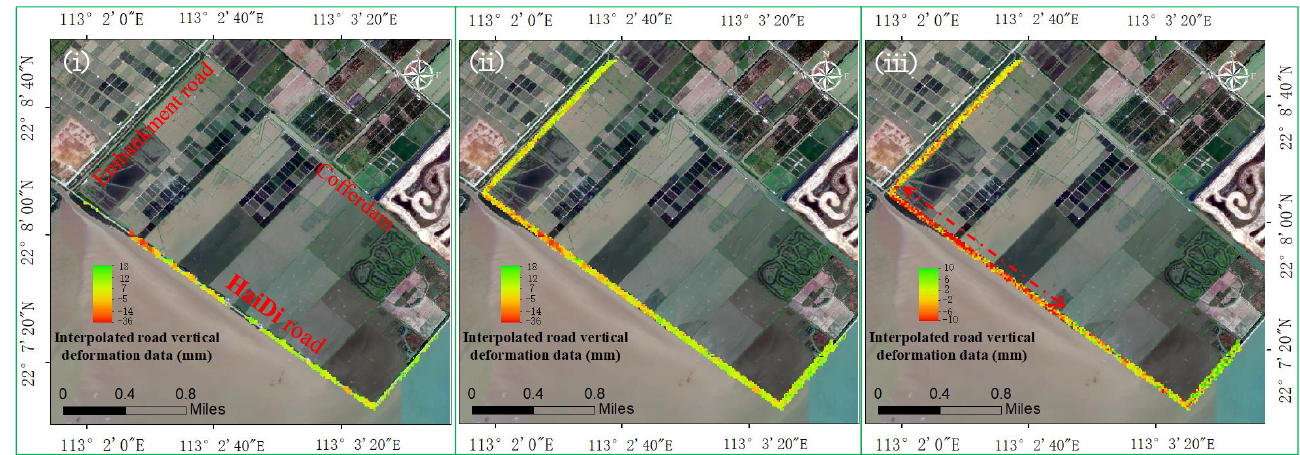
Figure 22. ( i ) Pavement deformation and settlement map integrating PS-InSAR and SBAS-InSAR ( ii ) Pavement deformation corrected by proximity interpolation and bilinear interpolation ( iii ) the image with deformation and settlement range adjusted to −1 0 – 10 (mm).